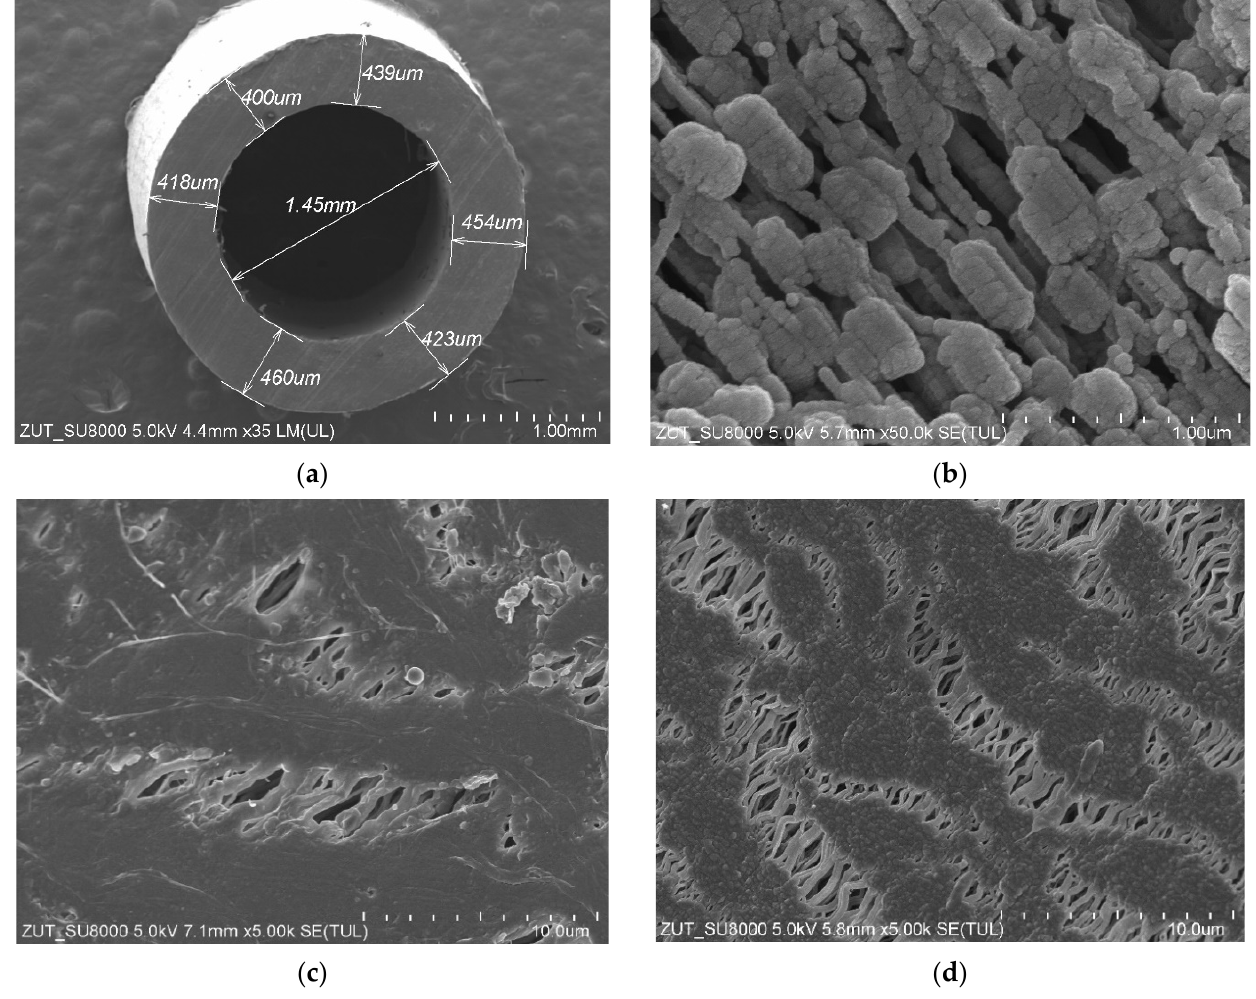
Figure 2. SEM images of the virgin capillary PTFE membrane: ( a ) capillary cross section; ( b ) wall cross section; ( c ) external surface; ( d ) internal surface.